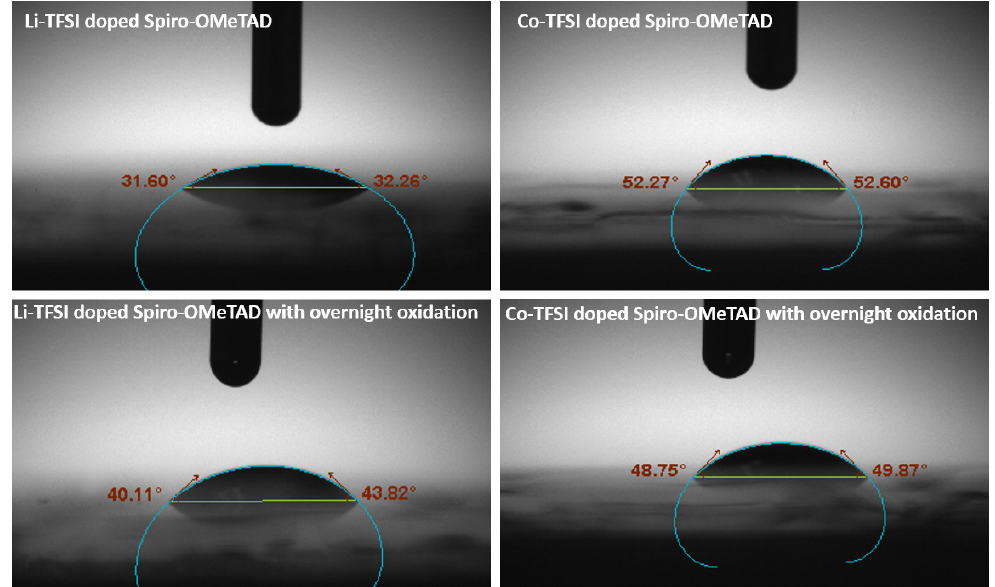
Figure 4. Contact angle measurements for LiTFSI-doped spiro-OMeTAD (31.60° and 40.11°, with and without overnight oxidation, respectively) and Co(III)TFSI co-doped spiro-OMeTAD (52.27° and 48.75°, with and without overnight oxidation, respectively).